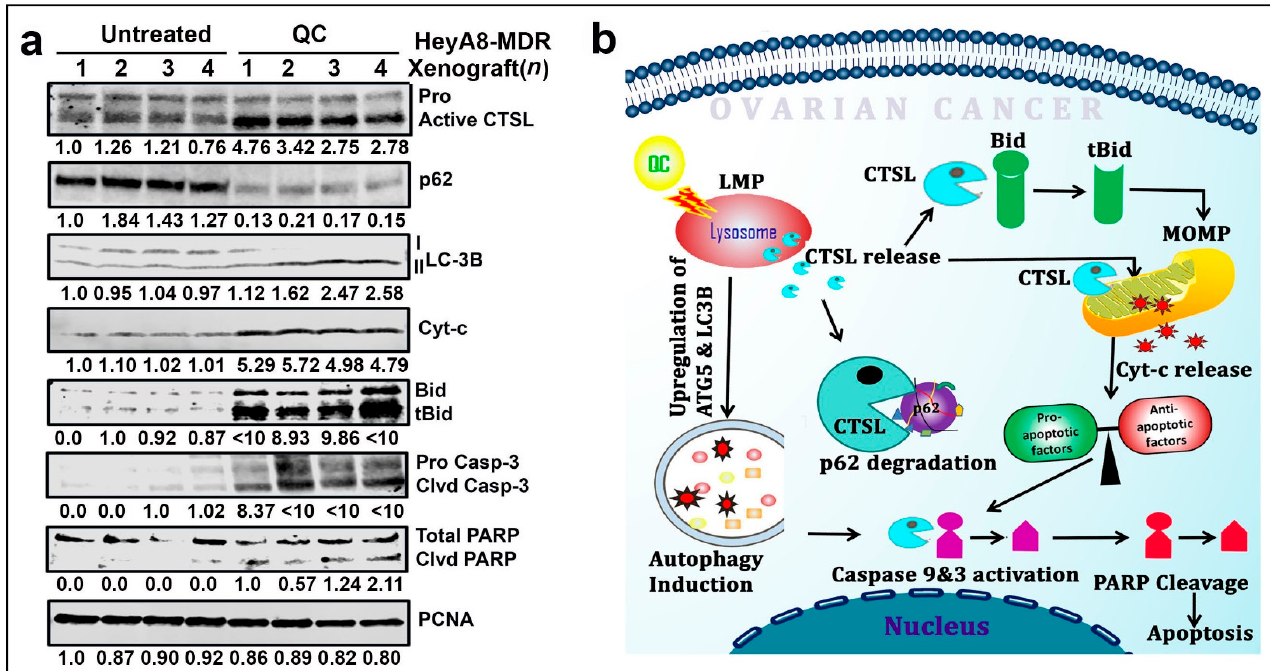
Figure 7. QC induces CTSL and suppresses tumor growth in the HeyA8-MDR xenograft model. ( a ) Immunoblot analysis was performed in the untreated and QC-treated HeyA8-MDR OC xenograft tumors against CTSL, p62, LC3BII, tBid, Cyt-c, cleaved PARP and cleaved caspase 3 expressions. ( b ) Schematic representation of the study. Abbreviations: QC: quinacrine; CTSL: Cathepsin-L; LMP: Lysosomal Membrane Permeabilization; MOMP: Mitochondrial Outer Membrane Permeabilization; tBid: truncated Bcl-2 family member(Bid); p62- ubiquitinbinding protein 62; Cyt c: Cytochrome-c; ATG5: Autophagy Related 5; LC3B: Autophagy marker protein Light chain 3B; PARP: Poly (ADP-ribose) polymerase.